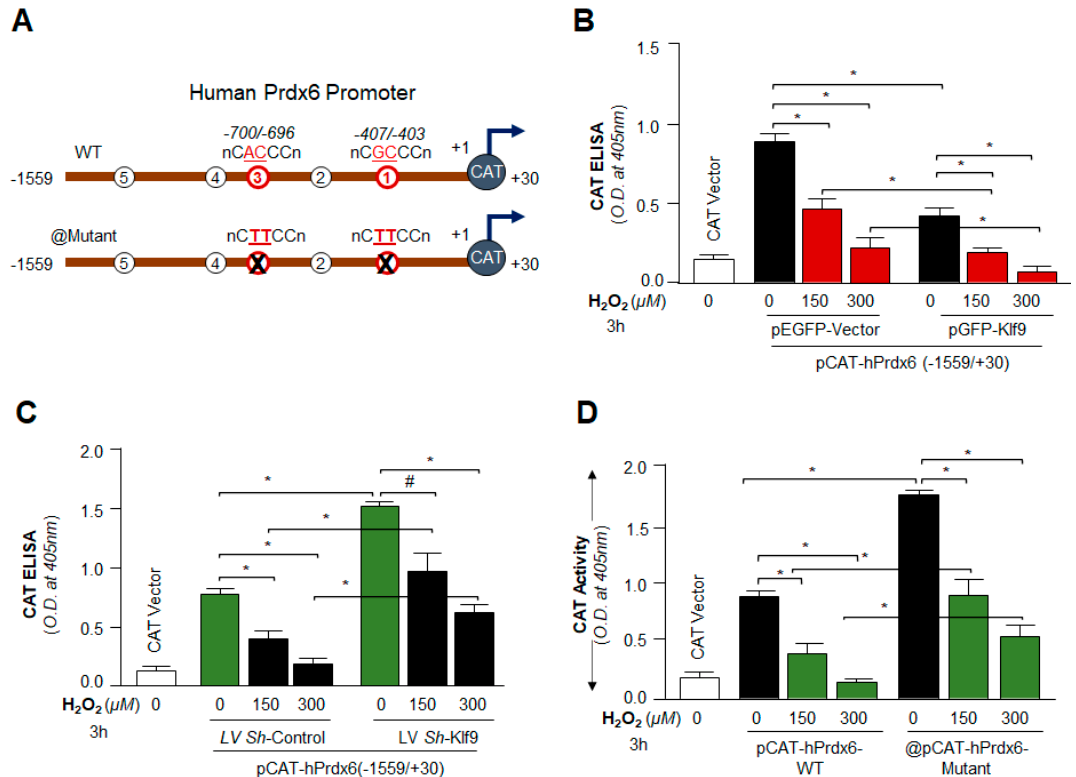
Figure 9. Transactivation assay revealed that Prdx6 transcription was repressed via Klf9 in condi- tion(s) of excessive amount of oxidant. ( A ) Schematic representation of human Prdx6 promoter [pCAT-hPrdx6 (-1559/+30)] showing Klf9 sites. ( B ) hLECs overexpressing Klf9 displayed a signifi- cant reduction in Prdx6 transcription. hLECs were co-transfected with pCAT-hPrdx6 (-1559/+30) WT along with pEGFP-Vector or pGFP-Klf9 plasmid constructs as shown. 48 h later transfectants were exposed to H 2 O 2 exposure for 3 h as shown, and CAT ELISA was performed to measure the Prdx6 promoter activity. Data are the mean ± S.D. of three independent experiments. * p < 0.001; GFP-Klf9 vs. EGFP-Vector transfected cells and H 2 O 2 treated versus untreated hLECs. ( C ) Transcription assay displayed increased Prdx6 promoter activity in Klf9 -depleted hLECs. LV Sh -Control and/or LV Sh -Klf9 infected hLECs were transfected with pCAT-hPrdx6 (-1559/+30) plasmid construct, 48 h later these cells were exposed to H 2 O 2 as indicated. Prdx6 promoter activity were determined after 3 h of H 2 O 2 exposure. Data are the mean ± S.D. of three independent experi- ments. # p < 0.05; * p < 0.001; LV Sh -Klf9 vs. LV Sh -Control and H 2 O 2 treated vs. untreated cells. ( D ) hLECs were transfected with human Prdx6 gene promoter (-1559/+30) linked to CAT wild type (WT) plasmid construct or its mutant at RKBE1 plus RKBE3. 48 h later transfectants were exposed to H 2 O 2 for 3 h as shown, and CAT ELISA was performed to measure Prdx6 promoter activity. Data are the mean ± S.D. of three independent experiments. * p < 0.001 mutant vs. wild-type and H 2 O 2 treated vs untreated cells.